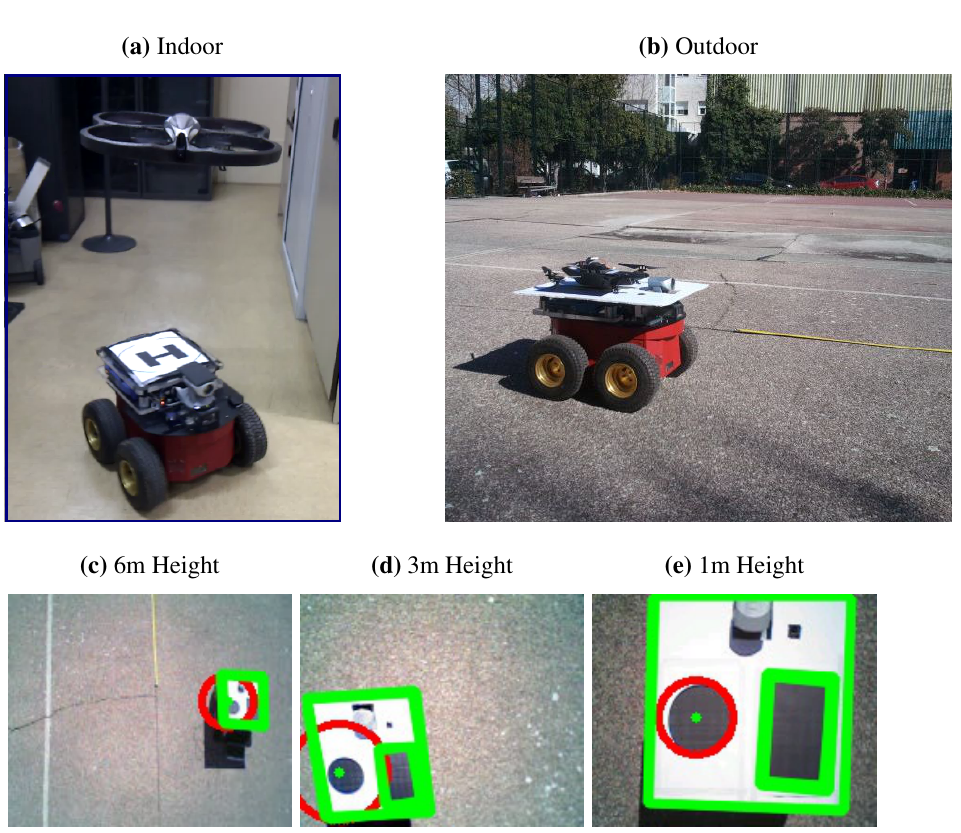
Figure 12. Initial Tests with real robots: ( a , b ) Communication and hovering. ( c ), ( d ) and ( e ) Aerial Images captured at different